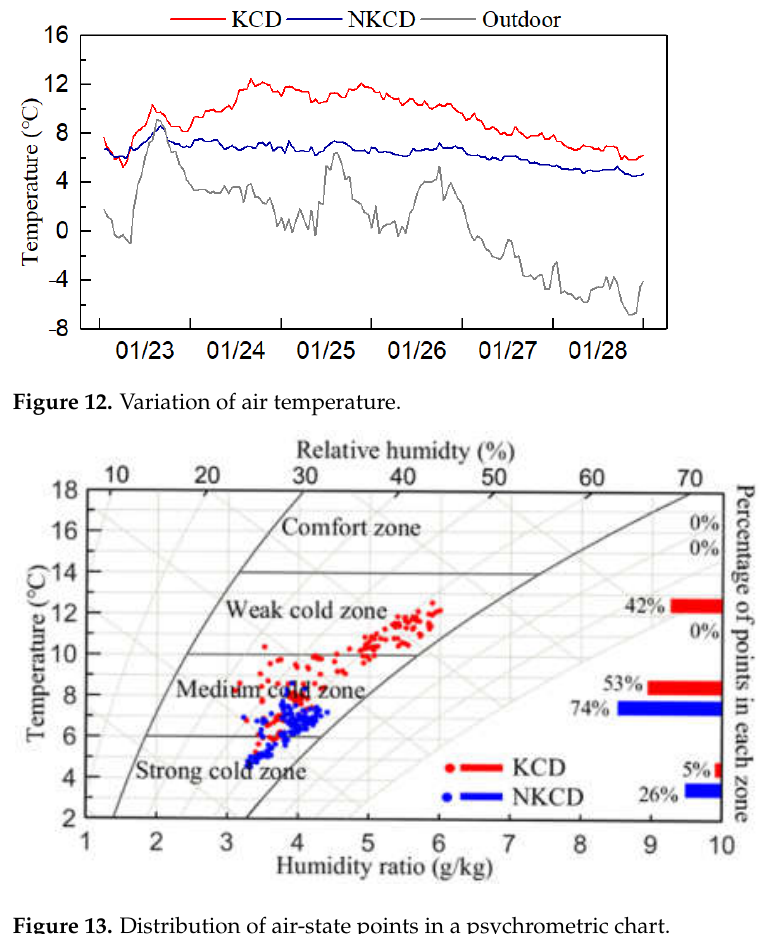
Figure 13. Distribution of air-state points in a psychrometric chart. The heated indoor temperature was calculated to be 14 ◦ C with a favorable relative humidity between 30% and 70%, according to the Design Standard for Energy Efficiency of Rural Residential Buildings. In a psychrometric chart, this relative humidity range was divided into four sections: comfort zone ( t ≥ 14 ◦ C), weak cold zone (14 ◦ C > t ≥ 10 ◦ C), medium cold zone (10 ◦ C > t ≥ 6 ◦ C), and strong cold zone (6 ◦ C > t ). As shown in Figure 13, the air-state measurement points in the NKCD and KCD did not reach the comfort